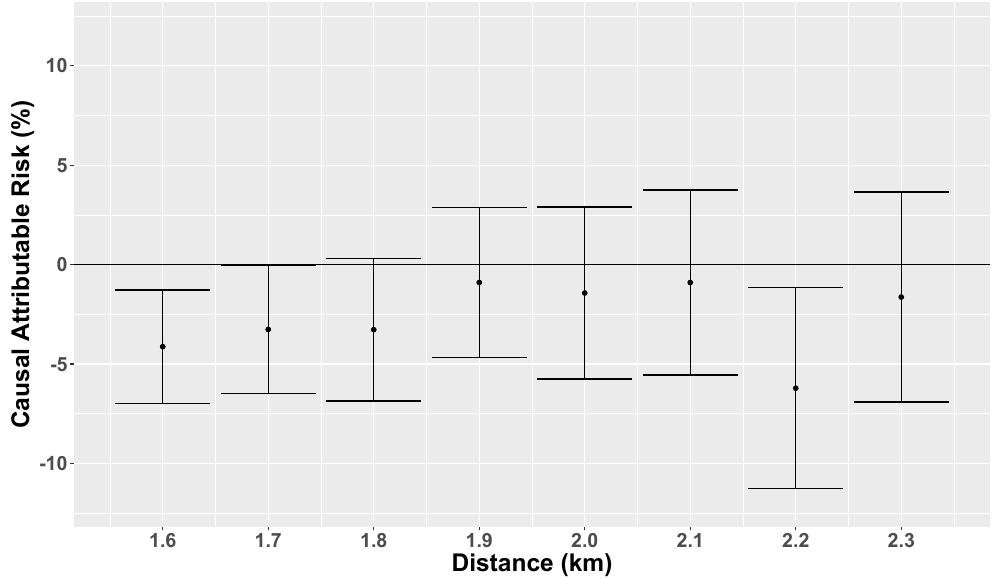
Figure A5. Estimated CAR of rhinoconjunctivitis in children, expressed as percentage points with whiskers indicate 95% confidence intervals and different distances to the copper mine. Data from children living in a rural mining community in the north of Chile,